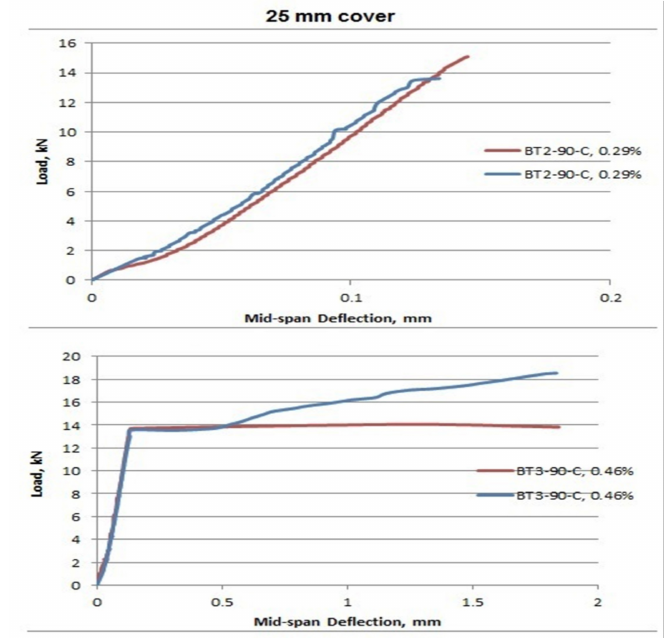
Figure 10. Mid-span load-deflection of TRC beams with woven fabric (2.5 cm) at the weft direction and 2.5 cm cover.